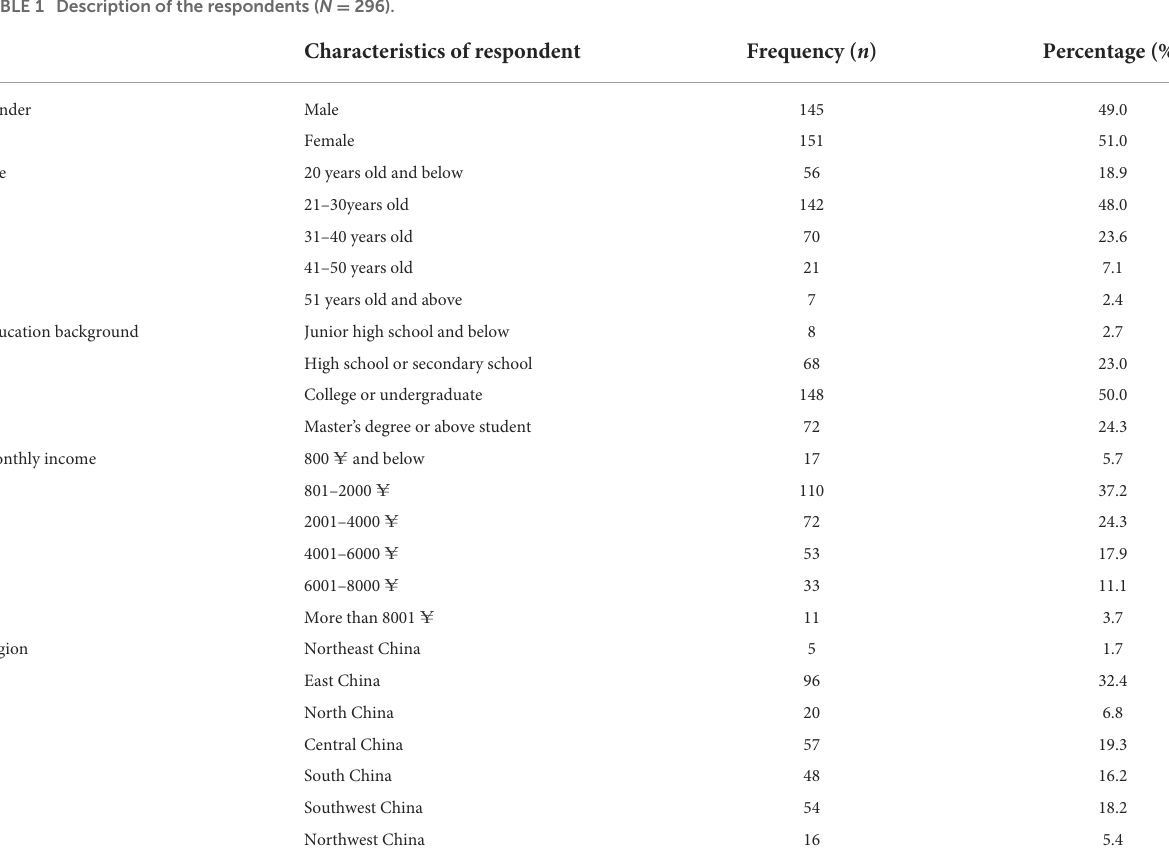
TABLE 1 Description of the respondents ( N =